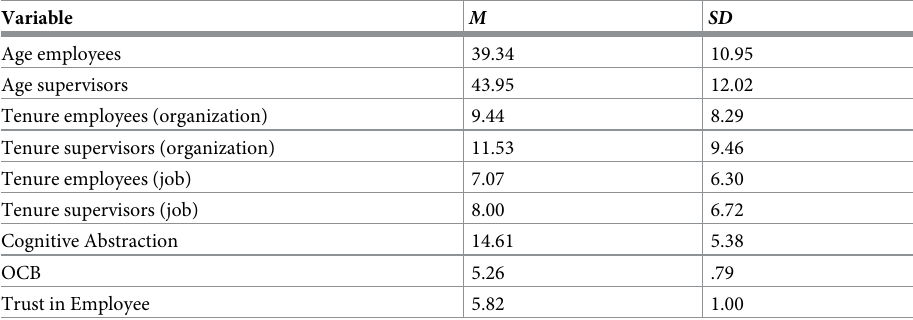
Table 1. Descriptive statistics for Study